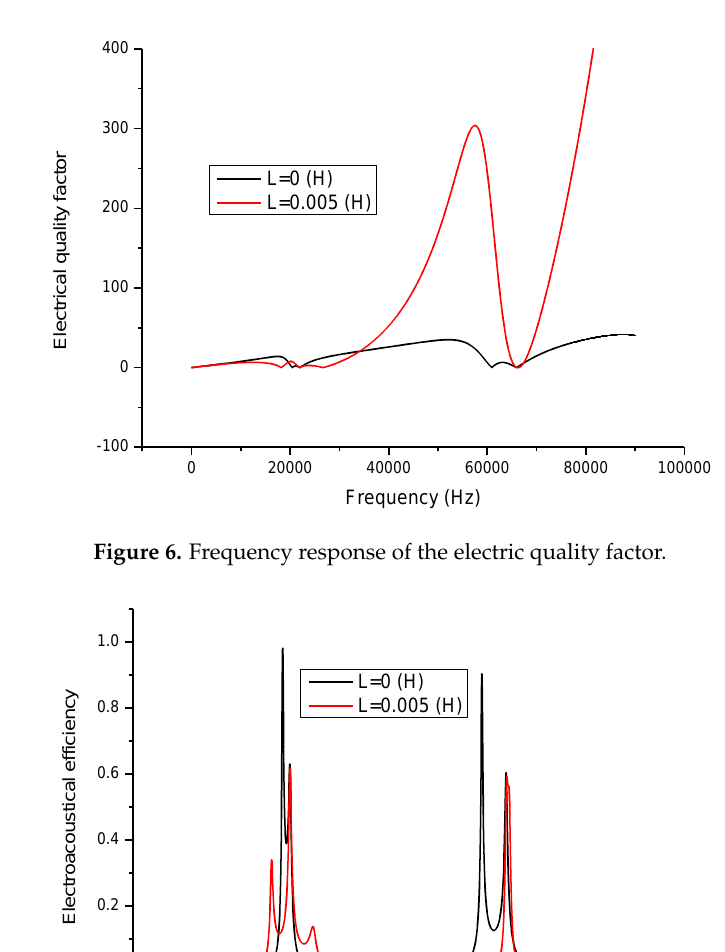
Figure 5. Frequency response of the input electric impedance.